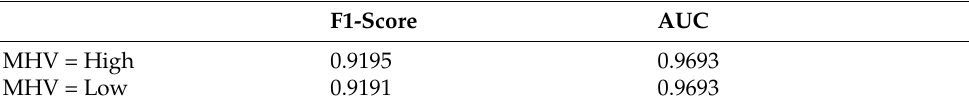
Table 5. BN model verification